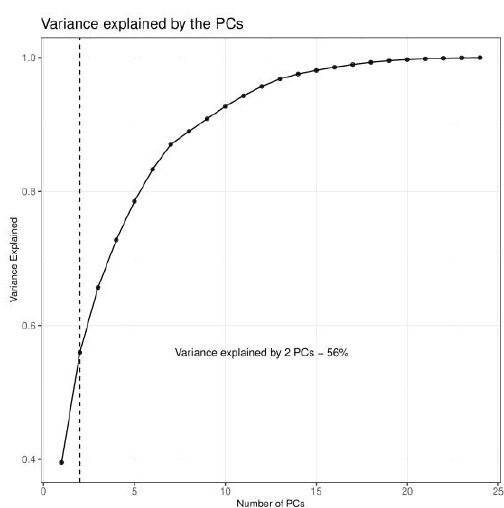
Figure A1. Cumulative variance explained by the leading two principal components of the annual maximum streamflow data across the Ohio River Basin. The two leading principal components explain ~39% and 16% of the total variance, respectively.